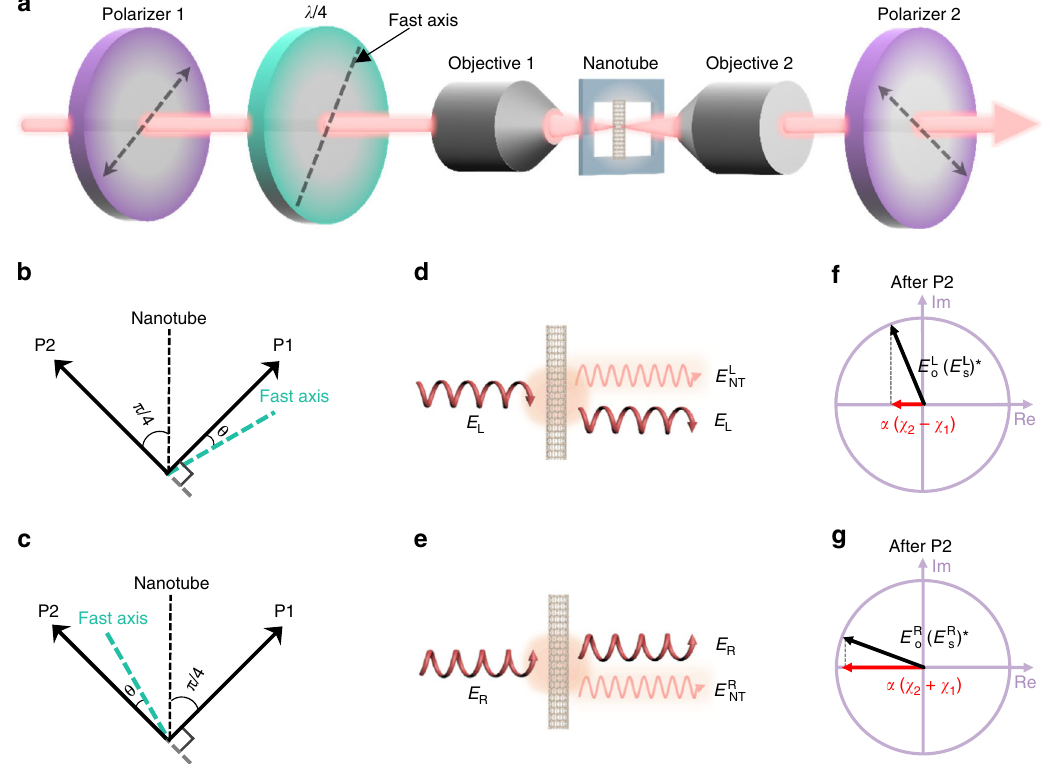
Fig. 1 Scheme of complex optical susceptibility measurement in a transmission geometry. a Scheme of experiment setup. Two polarizers were strictly perpendicular to each other. A quarter-wave plate was used to generate the elliptical chirality (left- or right-handed). A vertically placed carbon nanotube was put at the focus of the two confocal objectives. b , c Layouts of the polarization control and the nanotube. The nanotube was laid at the bisector of the two polarizers ’ axis. The fast axis of the wave plate was kept at a small angle ( θ ) to the polarizer axis. Polarizer 2 and polarizer 1 were abbreviated to P2 and P1. d , e Interference scheme of input left- ( E L )and right-handed ( E R )elliptically polarized light and nanotube forward-scattering fi eld ( E L f , g Illustrations of complex phase diagrams of the detected optical contrast signal with left/right elliptically polarized light excitation after polarizer 2, in which χ 1 contributes oppositely under two